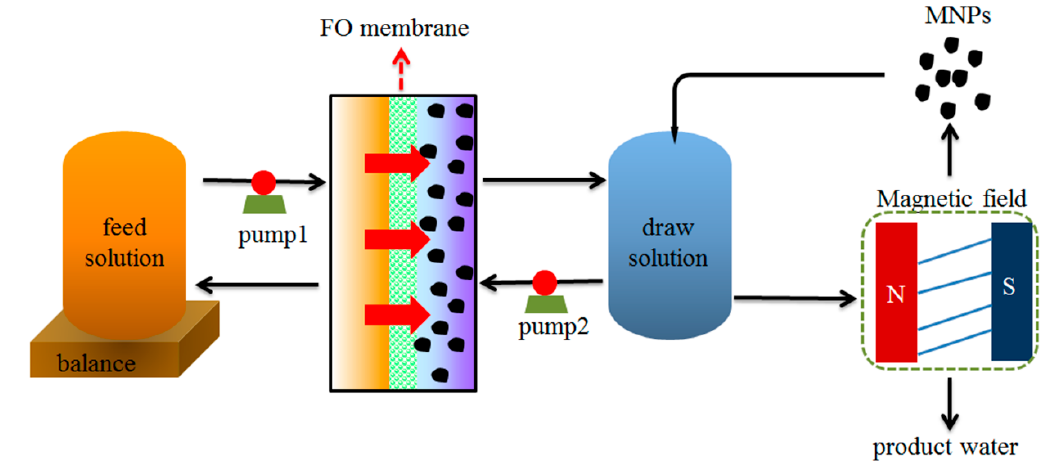
Figure 4. Schematic illustration of using functionalized magnetic nanoparticles as DSs in FO process. (MNPs, magnetic nanoparticles).